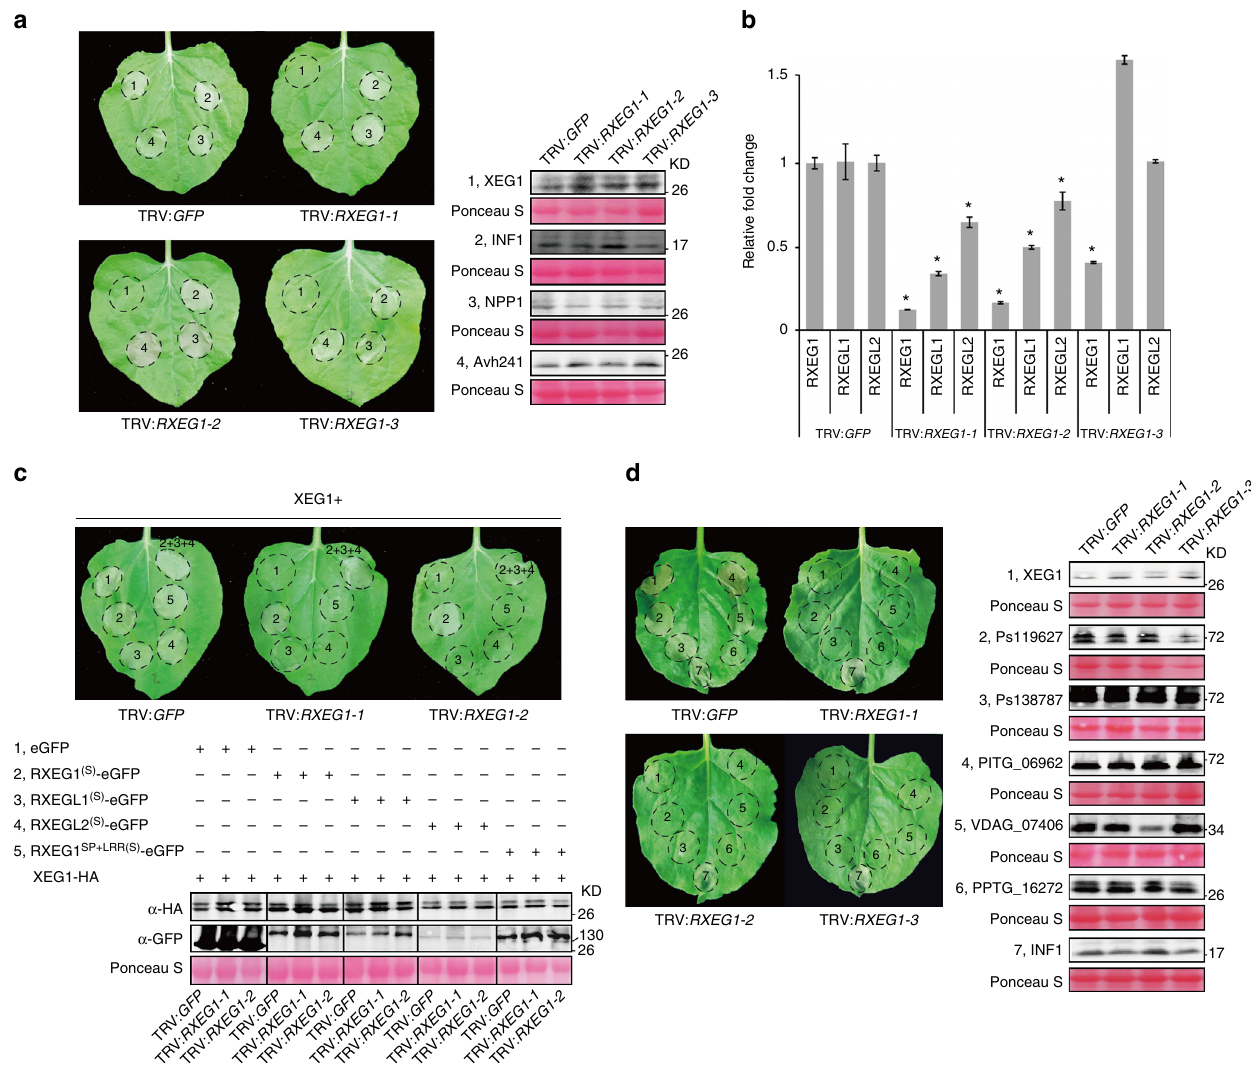
Fig. 2 RXEG1 mediates GH12 protein recognition in N . benthamiana . a Representative leaves showing cell death induced by expression of XEG1, INF1, NPP1, or Avh241 in N . benthamiana . Leaves ( n = 10) were photographed three days after agro-in fi ltration (dai). Accumulation of each protein was monitored at 2 dai with anti-HA antibody. The numbers used for western blots match the numbers on the leaves. Protein loading is indicated by Ponceau S staining. Experiments were repeated three times with similar results. b Relative transcript levels of RXEG1 and RXEG-likes in TRV: GFP - and TRV: RXEG1 -treated N . benthamiana . Leaves were collected from the same position of N. benthamiana of similar size and used for RNA isolation. The transcript levels were determined by qRT-PCR, normalized with EF-1 α , and expressed as mean fold changes [ ± standard error (s.e.m.)] relative to TRV: GFP -treated leaves, which was set as 1. *, signi fi cant differences ( P < 0.05, Student ’ s t -test). Similar results were obtained in three independent experiments. c Representative leaves showing expression of synthesized RXEG1 restored XEG1-induced cell death in N . benthamiana treated with TRV: RXEG1-1 or TRV: RXEG1-2 . XEG1 was co- expressed with P19 and RXEG1 (S) , RXEG1 LRR(S) , RXEGL1/2 (S) , or a mixture of RXEG1 (S) and RXEGL1/2 (S) in N . benthamiana leaves treated with TRV: GFP , TRV: RXEG1-1 , or TRV: RXEG1-2 . In fi ltrated leaves ( n = 6) was photographed at 3 dai. Total protein was isolated from in fi ltrated leaves at 2 dai and analyzed with anti-HA and anti-GFP antibodies. Protein loading is indicated by Ponceau S staining. Experiments were repeated three times with similar results. d Representative leaves showing cell death induced by expression of various GH12 proteins and INF1 in N . benthamiana leaves treated with TRV: GFP or TRV: RXEG1 . GH12 proteins and INF1 were transiently expressed in N . benthamiana . In fi ltrated leaves ( n = 10) were photographed at 3 dai. Total protein was isolated from in fi ltrated leaves at 2 dai and accumulation of each protein was analyzed by western blot with anti-HA antibody. The numbers used for western blots match the numbers on the leaves. Protein loading is indicated by Ponceau S staining. Experiments were repeated three times with similar